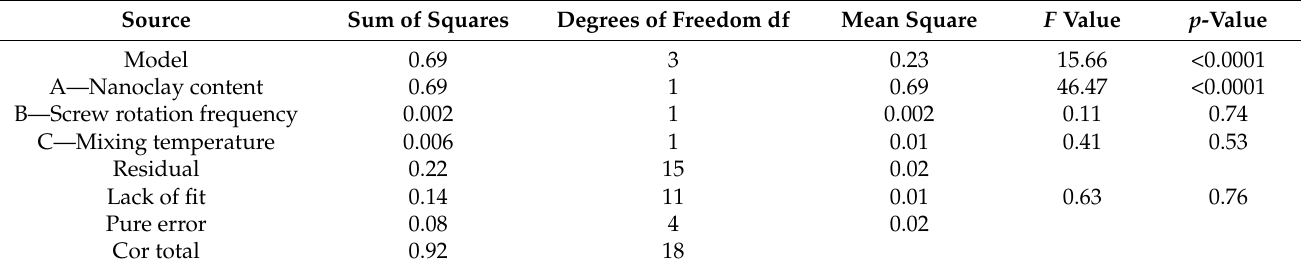
Table 6. Analysis of variance for the linear regression model: flexural modulus.